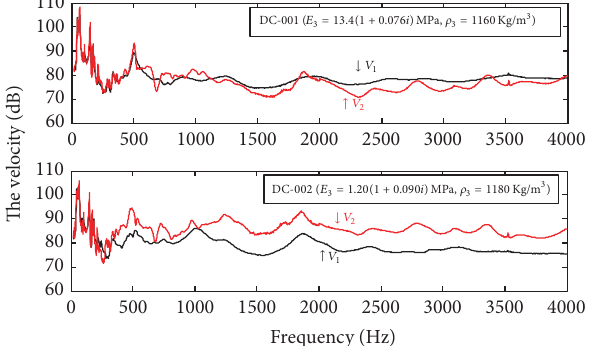
Figure 12: Comparison of the mean squared velocities of base plates and outer decoupling layer surfaces.